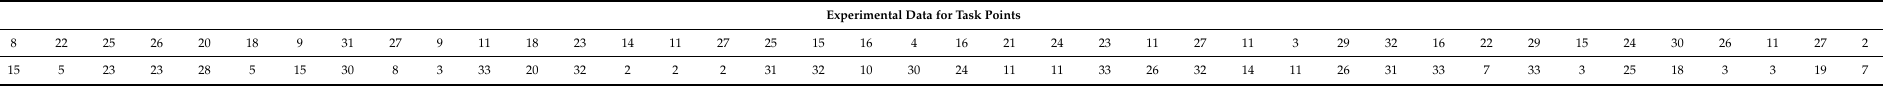
Table A1. Data used in the experiment (provided as